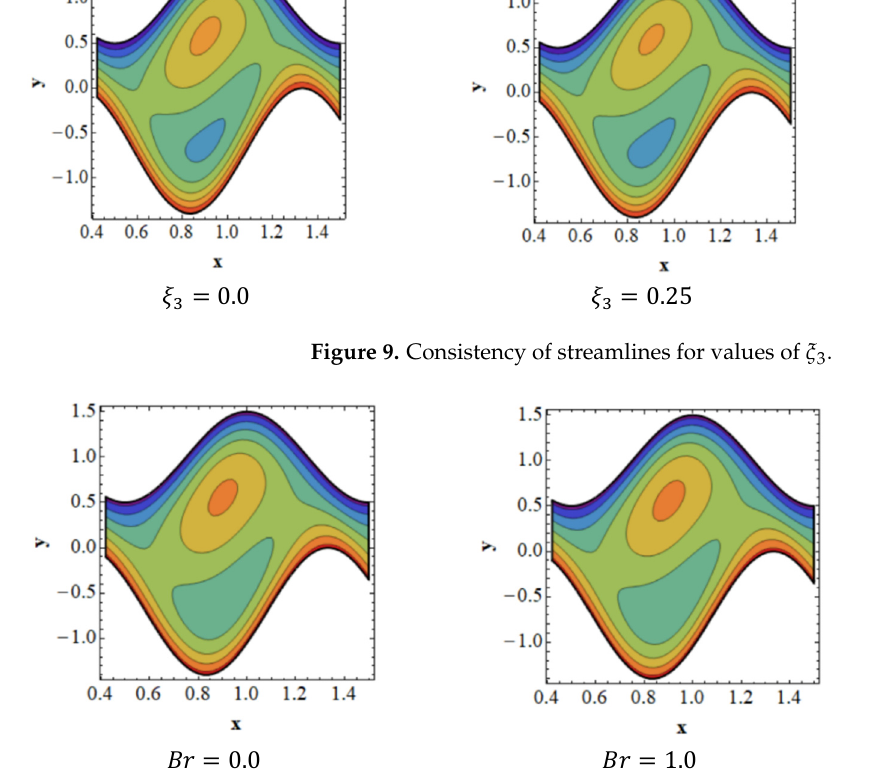
Figure 10. Consistency of streamlines for values of 𝐵𝑟.